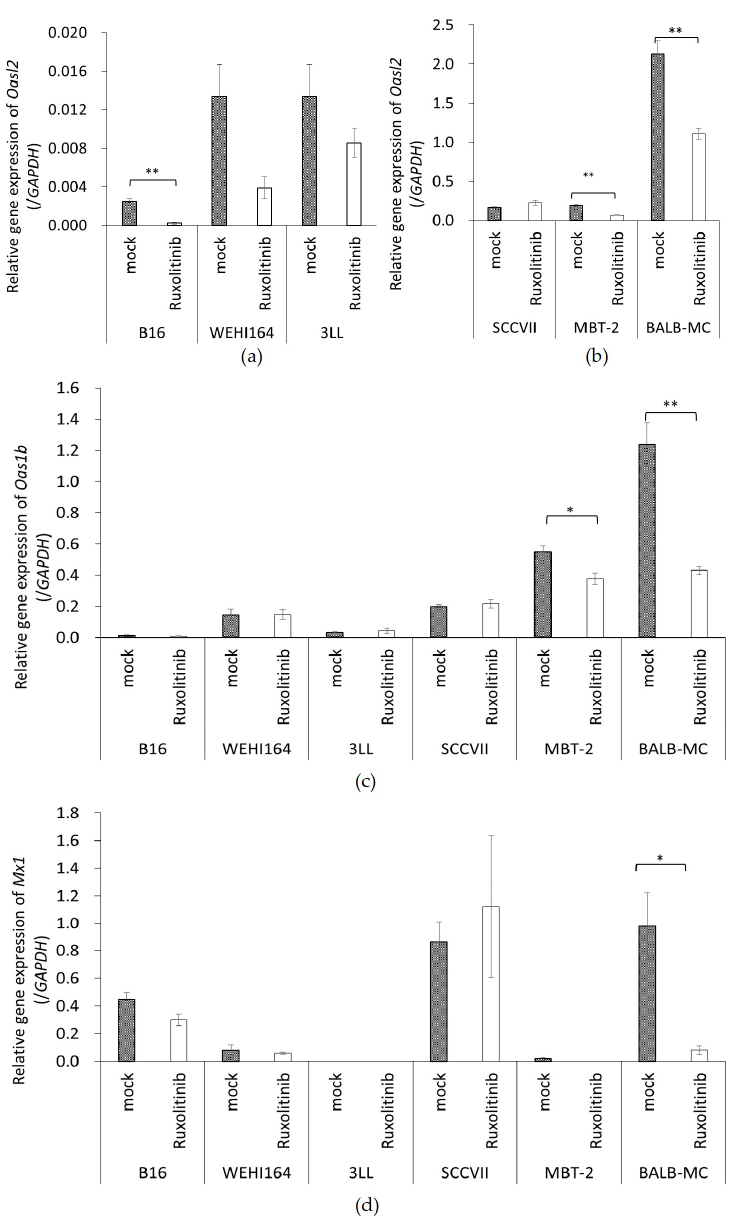
Figure 4. ISGs expression after ruxolitinib. Tumor cells were cultured in medium with (ruxolitinib) or without (mock) ruxolitinib for 20 h. Then, ( a , b ) Oasl2 , ( c ) Oas1b , and ( d ) Mx1 gene expression was quantified by qPCR. Gene expression was normalized with GAPDH (* p < 0.05, ** p <